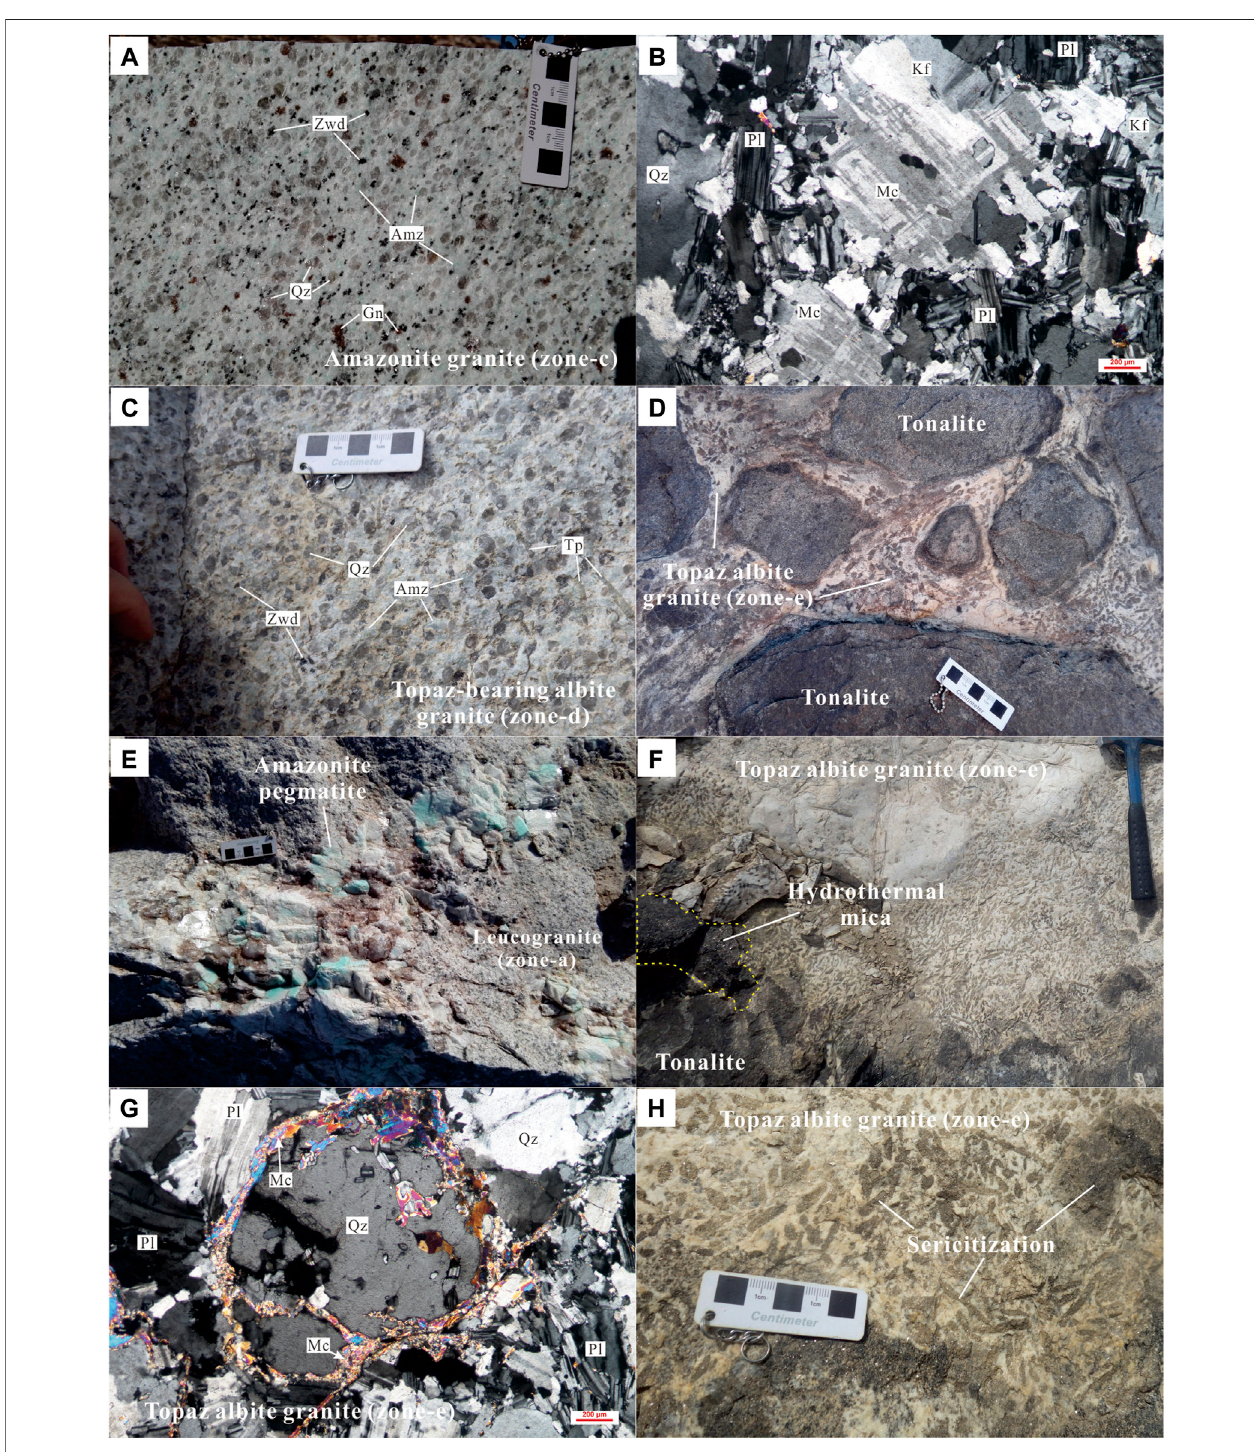
FIGURE3| Fieldphotographs andmicrophotographsshowinglithologicalcharacteristicsoftheBSTpluton.Mineralsymbols:Qz – quartz,Pl – albite,Kf – K-feldspar, Amz – amazonite, Zwd – zinnwaldite, Mc – microcline, Tp – topaz, Gn – garnets. (A) Porphyritic texture of amazonite granite from zone – c. Hand specimen. (B) Microphotograph showing the texture of amazonite granite. Microcline with cross – hatched twins has corroded K-feldspar and albite grains into optically continuous relict. Crossed polarizers. (C) Prismatic topaz crystals occur as a phenocrysts in zone – d. Hand specimen. (D) The zone – e has penetrated and replaced the overlying tonalite (country rock). (E) Amazonite pegmatite vein in zone – a. (F) Clustered crystals of hydrothermal mica occuring in the contact between the zone – e and tonalite. (G) White mica and twin-free albite occurring as vein along mineral grains and fractures in zone-e. (H) Prismatic topaz crystals were replaced by hydrothermal